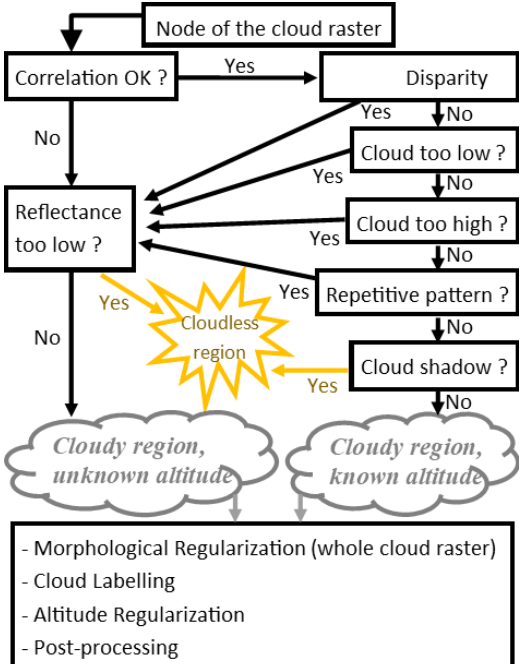
Figure 13. Decision tree of the cloud detection algorithm for Level-1 VEN μ S products.